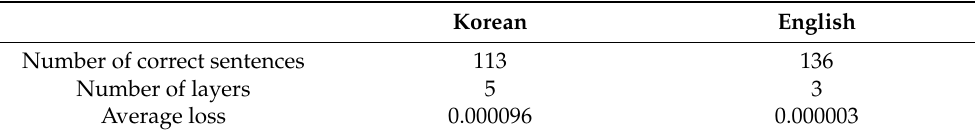
Table 4. Comparison between Korean and English